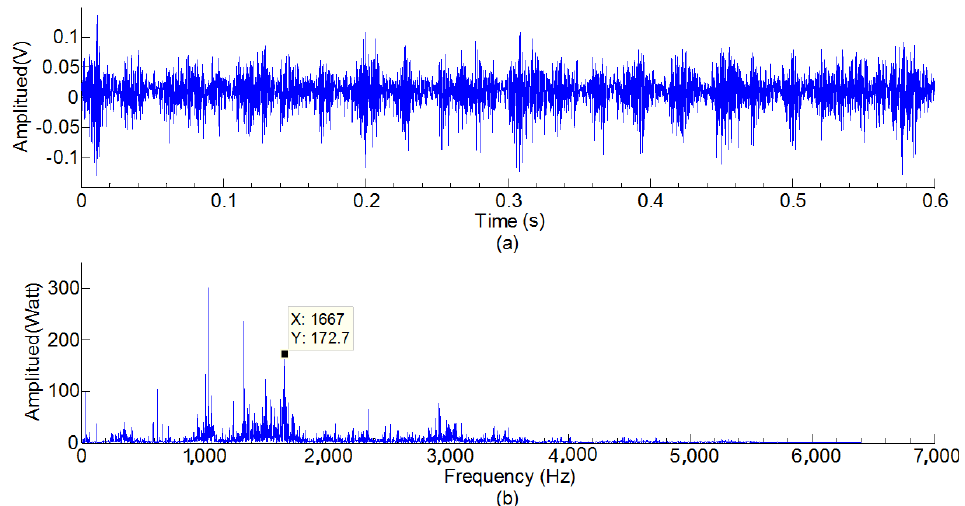
Figure 10. Gear experimental vibration signal and its spectrum. ( a ) Gear experimental vibration signal; ( b ) spectrum of gear vibration signal.